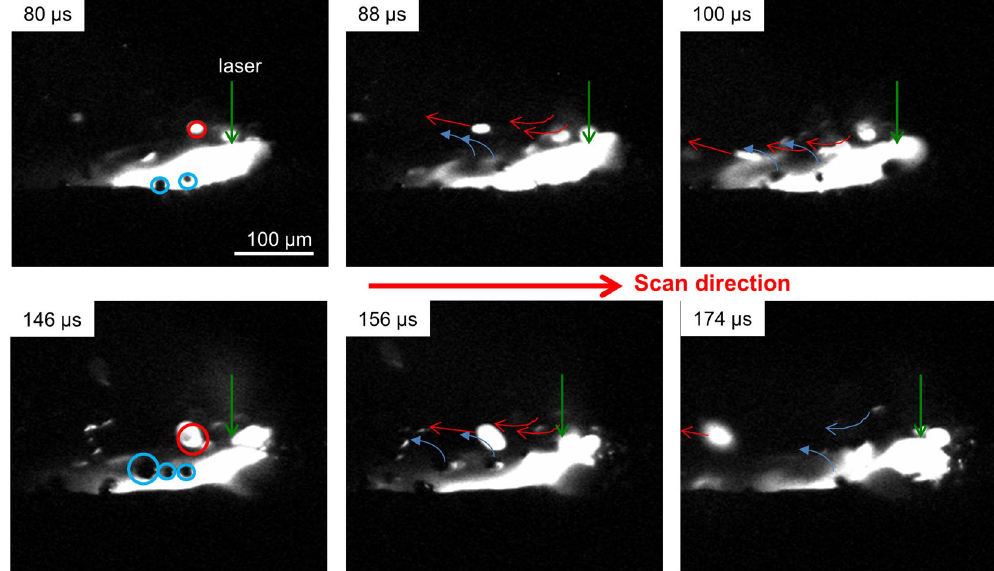
Figure 4. High resolution imaging of the melt pool formation at 500 kfps. To more clearly observe the rapid heating and incandescence of the entrained particles, the external illumination source is turned off. The laser power for the time sequence shown is P = 300 W and u = 1.5 m/s. The series of images show the time progression from 80 µ s to 174 µ s. As the laser is scanned from left to right, particles are observed being swept up and backward with the arrow denoting the movement. The first image at 80 µ s shows the location of the laser spot (green arrow) at the front of the melt pool. Hot particles are white in the image (circled in red) and cold particles are black (circled in blue). At 88 µ s, the cold particles are lifted up and swept in a motion depicted by the blue arrows. Similarly hot particles that exit the laser beam is swept in a motion depicted by the red arrows. At 146 µ s, new cold and hot particles are being entrained and the process